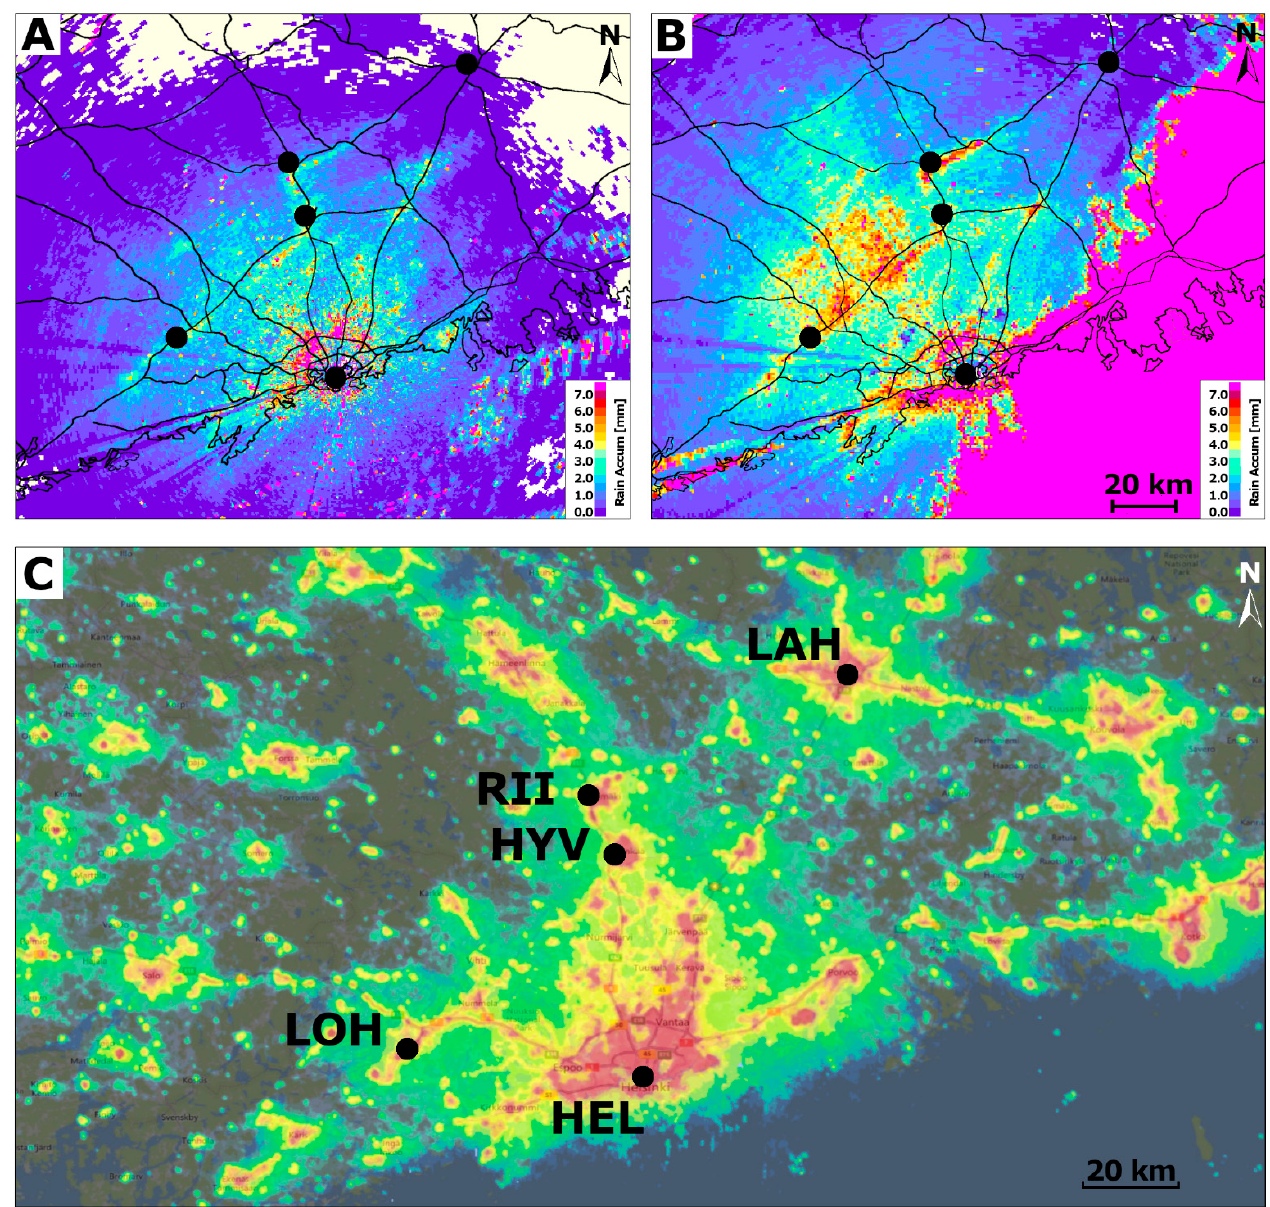
Figure 2. Accumulated reflectivity patterns, as observed by the Kumpula weather radar ( A ) on 3 October 2007, 19:00 UTC, and ( B ) 5 October 2007, 19:00 UTC, as well as the ( C ) corresponding night light map (source: www.lightpollutionmap.info, accessed on 13 December 2021) of the same area, with the relevant urban reference points (LOH: Lohja; HEL: Helsinki; HYV: Hyvinkää; RII: Riihimäki; LAH: Lahti). In A, birds extend over major parts of the map (purple to red) with some ships (dotted pink lines in S) and showers on the sea (larger pink dots in E). In ( B ), the bird pattern is similar to ( A ), though confined by rain (pink